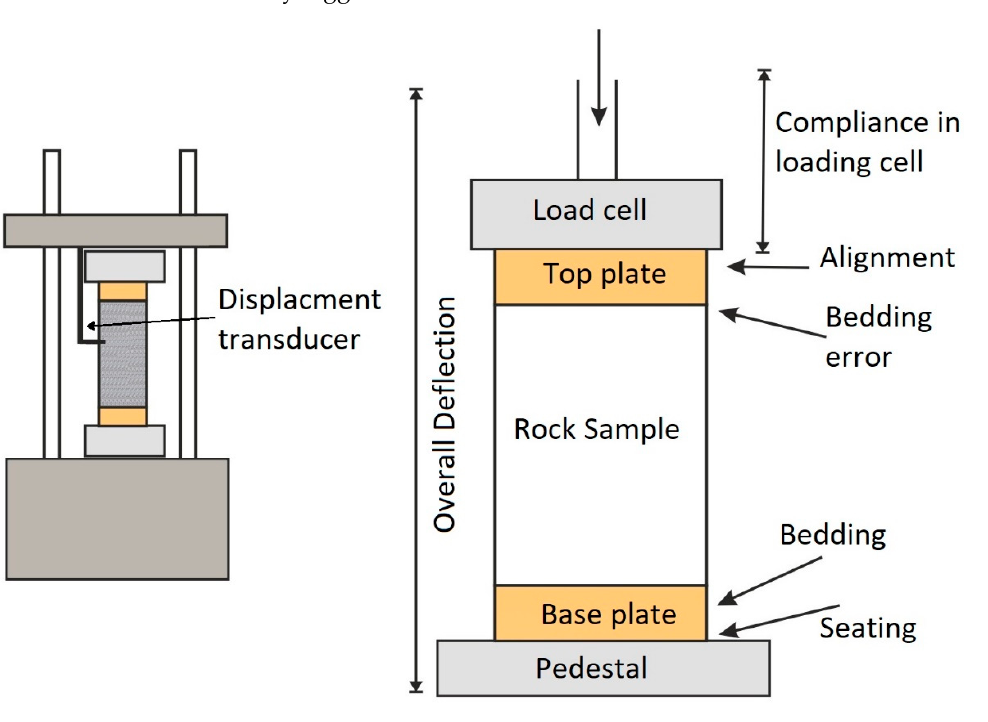
Figure 1. Regular UCT testing device [30].